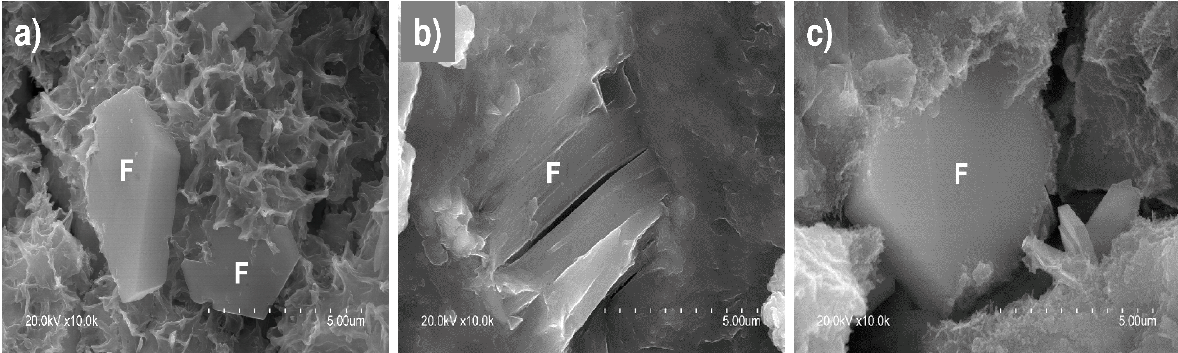
Figure 10. Friedel’s salt in 56-d 0.5 M NaCl-soaked pastes (×10,000): ( a ) OPC; ( b ) M1; ( c ) M2. The pastes exposed to the 0.3 M Na 2 SO 4 solution were observed to form gypsum de- posits clustering primarily in pores (Figure 11a), where the conditions for nucleation were most favourable [66,67]. Typically elongated needle-like ettringite (Figure 11b) was also